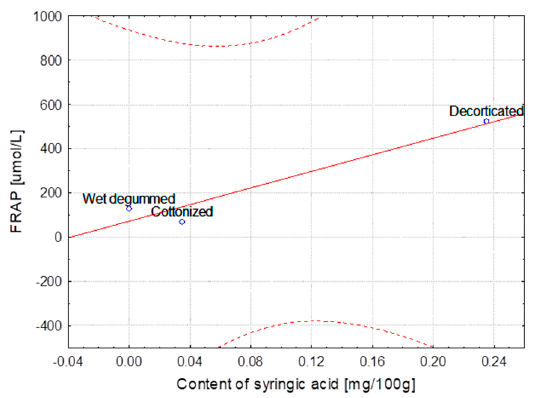
Figure 6. Variety of flax MODRAN—Dependence of FRAP [ μ mol/L] vs. content of syringic acid [mg/100 g] (y = 72.254 + 1875.476x; C = 95%).